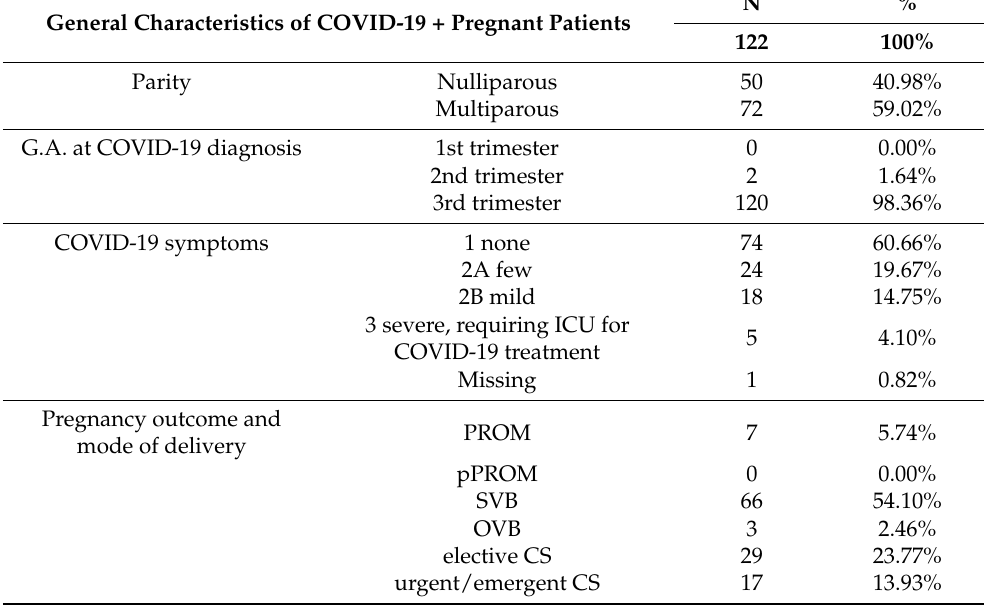
Table 1. Cont. General Characteristics of COVID-19 + Pregnant